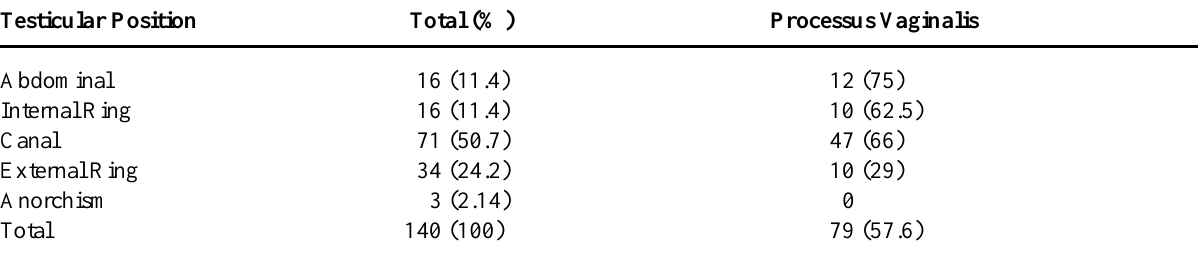
Table 1 – Testicular position in patients with